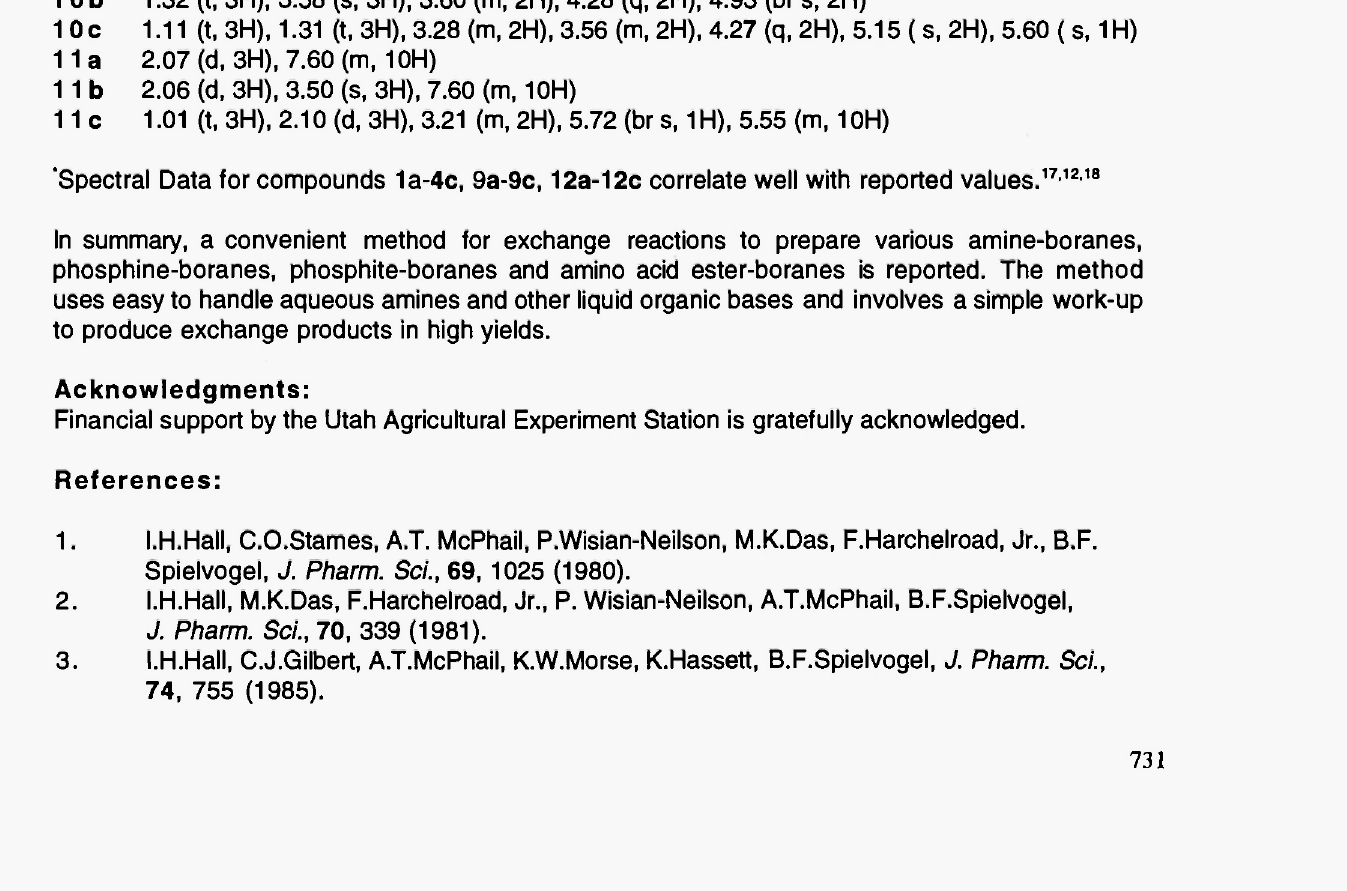
Table III. 1 H NMR (CDCI